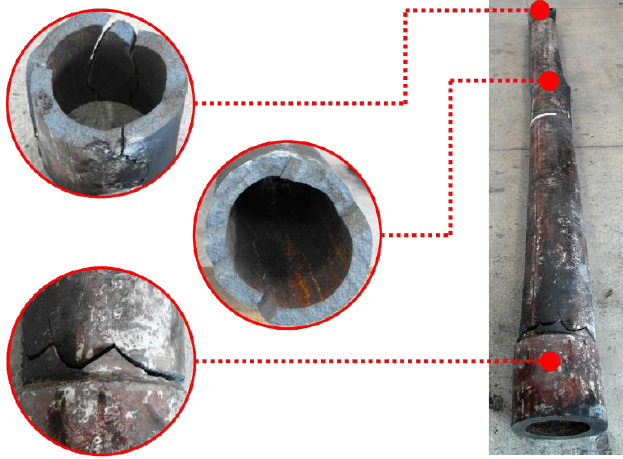
Figure 9. View of the column after end of the test (the column composed of parts).